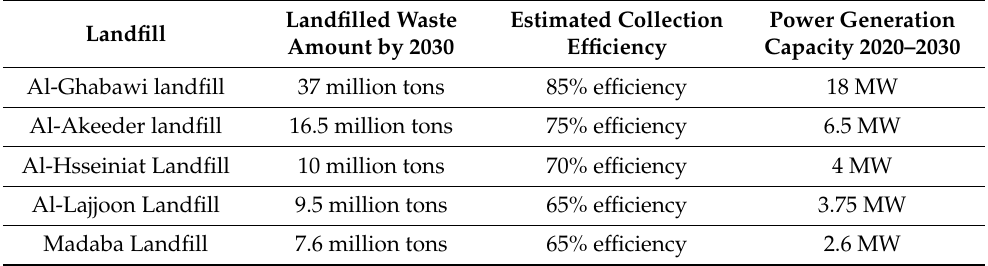
Table 3. Energetic potential of the LFG recovery from Jordanian